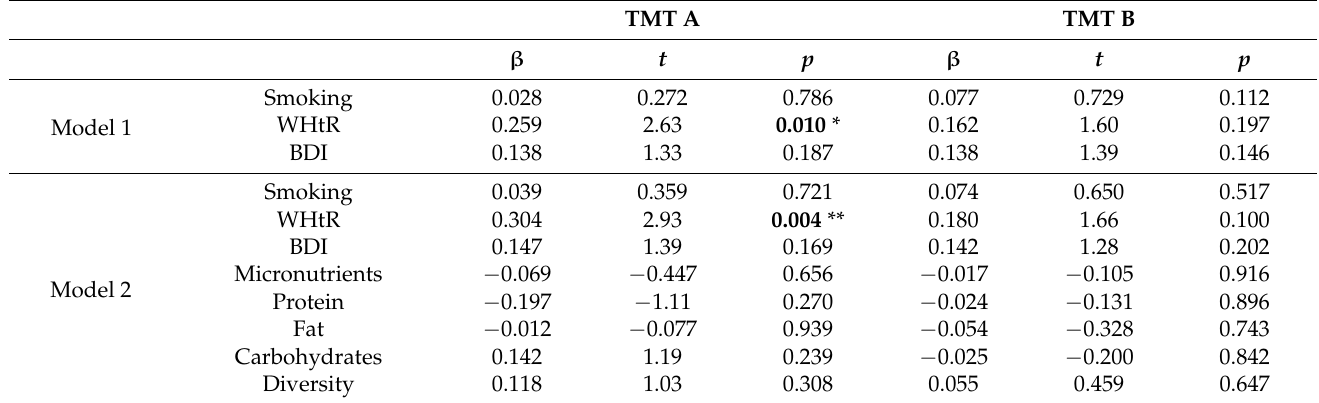
Table 4. Association of nutritional behavior with TMT